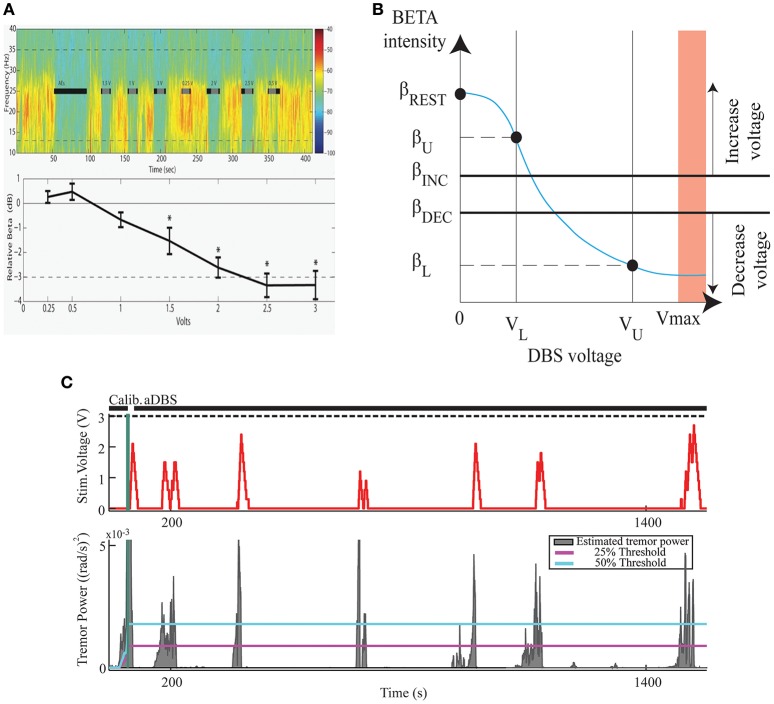
The Development of a Closed Loop System for PD Tremor. (A) Voltage dependent attenuation of STN beta band power; top panel- time frequency spectrogram, black bars indicate periods of STN DBS; lower panel group averaged relative beta band power at different DBS voltages. (B) Dual threshold control policy diagram; βREST–beta power no DBS at rest; βU, βL–beta power at lower and upper limits of DBS voltage; βINC, βDEC–beta power of upper and lower thresholds. (C). Example of STN KCL-DBS using dual tremor power thresholds (lower panel blue and magenta lines). DBS voltage (upper panel) follows tremor power and remains off for much of the trial when there is no tremor.